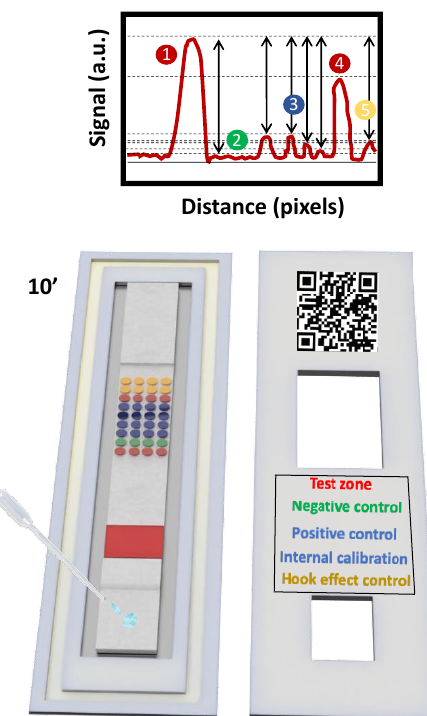
Figure 1. Schematic representation of ( A ) the portable device that contains all the elements required for the on-site extraction of the allergenic proteins. Specifically, these elements enable the grinding (30 s), filtration (30 s), and incubation of the sample with the extraction buffer for 30 min. ( B ) The proposed AuNPs-based LFµIA with microarray layout contains replicate assays for the in-situ detection of peanut and almond allergens, an internal signal calibration, and positive, negative, and hook effect control assays in 10 min.